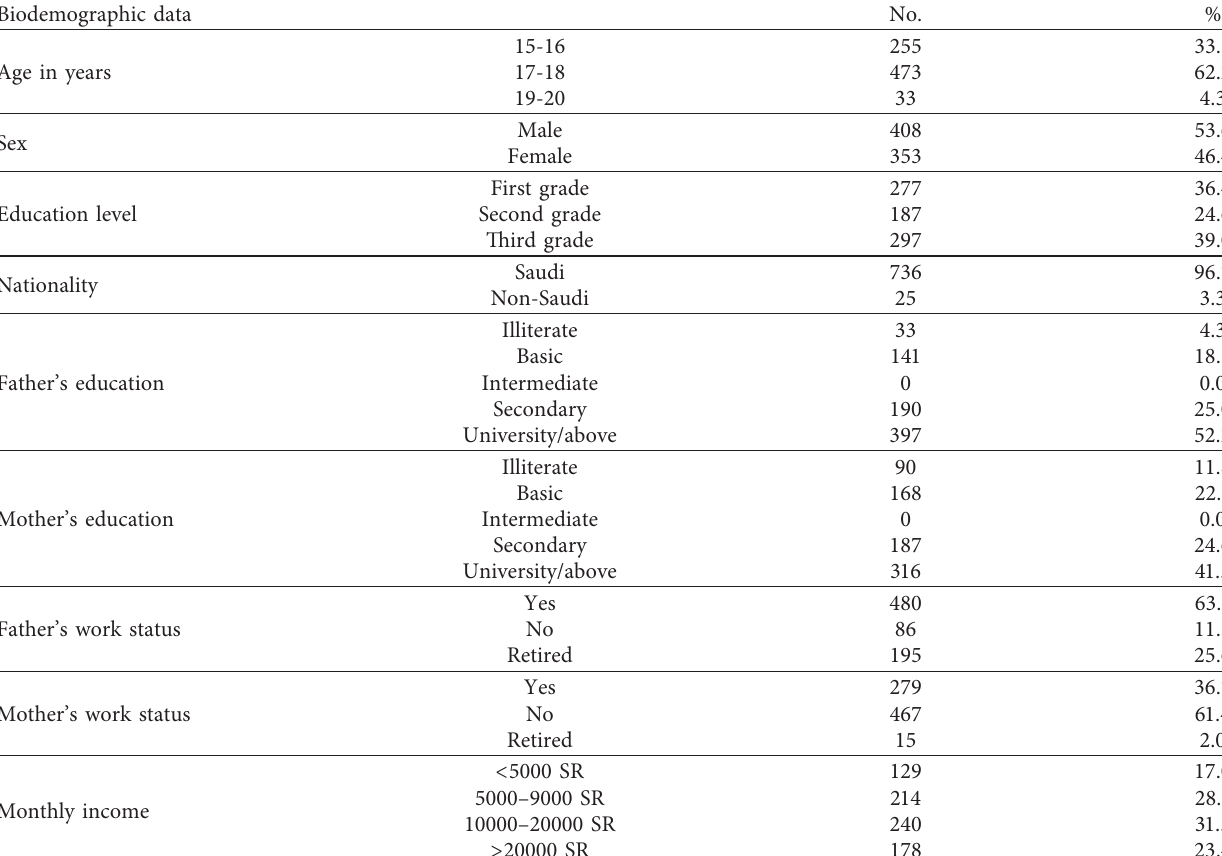
Table 1: Biodemographic data of secondary school students in Abha City, southern Saudi Arabia. Biodemographic data